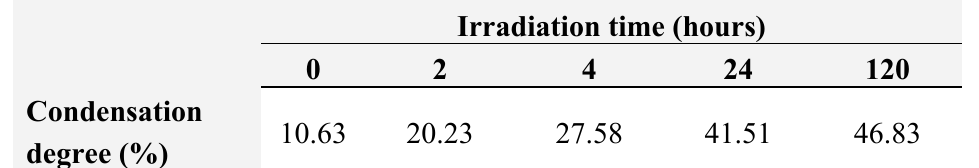
Table 4. Condensation degree of unirradiated and irradiated BCMP acidolysis